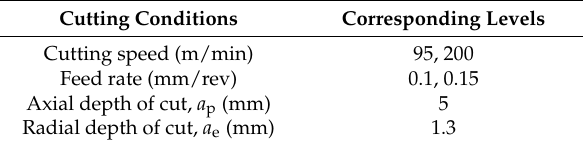
Figure 4. Schematic view of step shoulder milling of Ti-6Al-4V ( D c is the cutter diameter, a p and a e is the axial and radial depth of cut respectively). Table 1. Cutting conditions and levels used for accurate flow rate computation.